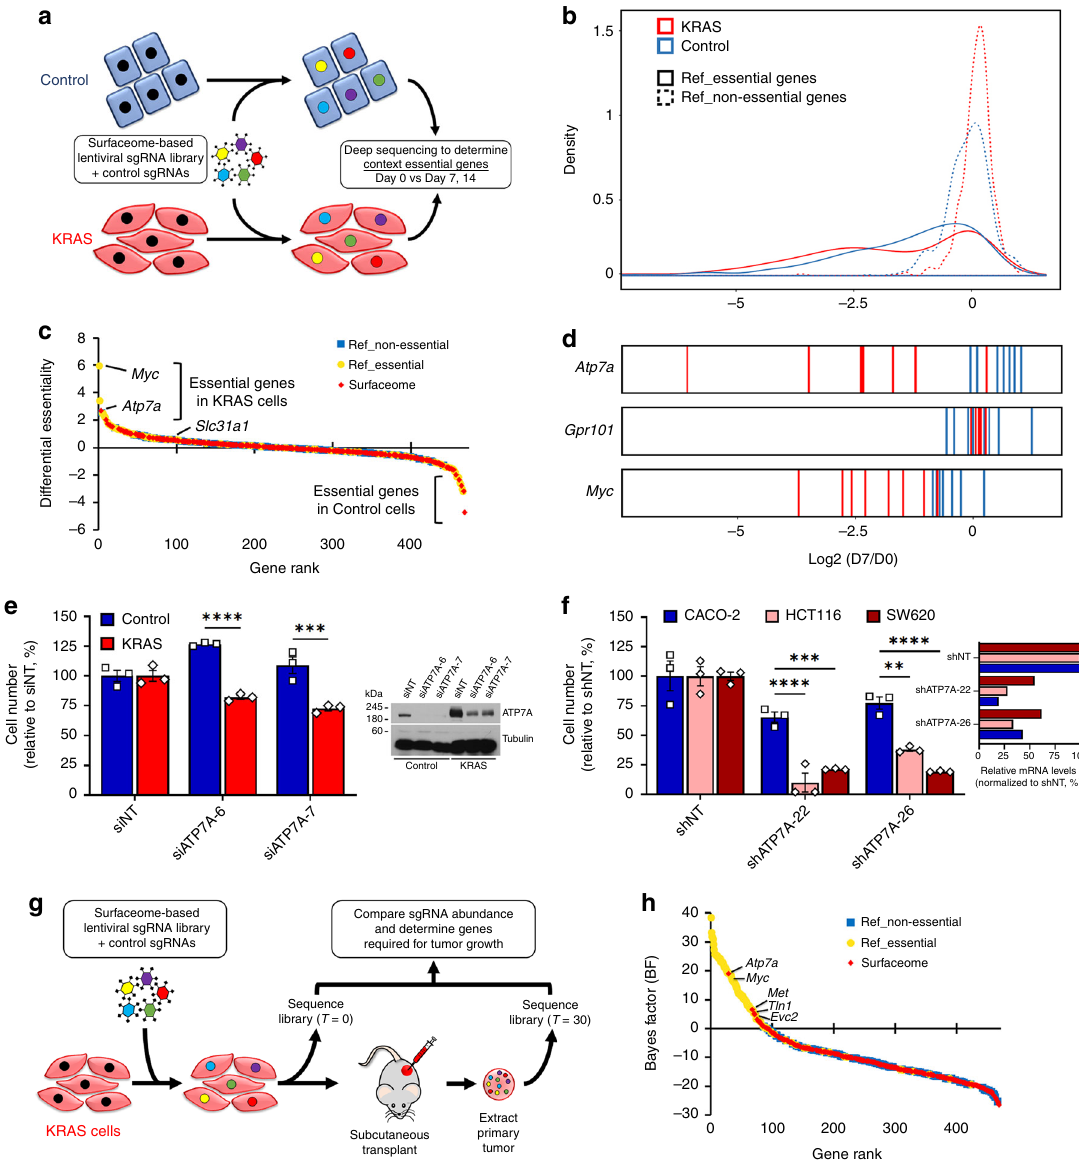
Fig. 2 Identi fi cation of ATP7A as a vulnerability for KRAS-addicted CRC cells. a Experimental design for identi fi cation of KRAS-speci fi c vulnerabilities by in vitro CRISPR/Cas9 screening. b Graph depicting the fold-change distributions of gRNAs targeting essential (solid lines) and nonessential (dashed lines) genes at day 7 after infection of Control and KRAS cells with KRAS-library. c Waterfall graph showing differential essentiality scores between Control and KRAS cells, depicting genes coding for cell-surface proteins signi fi cantly altered by KRAS G12V (red diamonds) and reference genes coding for proteins known to be essential (green circles) or non-essential (blue squares). d Bar graphs illustrating the Log2 FC of the eight gRNAs targeting Atp7a, the non- essential gene Gpr101 and essential gene Myc at day 7 in Control (blue) and KRAS (red) cells. e Bar chart indicating the relative cell viability of Control and KRAS cells after ATP7A knockdown. IB for ATP7A showing the ef fi cient knockdown by RNAi (right). Data represent n = 3 independent experiments with fi ve replicates, and n = 3 independent experiments (right). *** P = 0.0001; **** P < 0.0001. f As in e CRC cells were analyzed for cell viability upon ATP7A knockdown. Graph showing the ef fi cient knockdown of ATP7A as measured by qPCR (right). Data represent n = 3 independent experiments with seven replicates, and two technical replicates (right). **** P < 0.0001 (CACO-2 versus HCT116, shATP7A-22); *** P = 0.0008 (CACO-2 versus SW620, shATP7A-22); ** P = 0.0027 (CACO-2 versus HCT116, shATP7A-26); * P < 0.0001 (CACO-2 versus SW620, shATP7A-26). g Experimental design for the signi fi cantly regulated by KRAS G12V (red diamonds), or proteins that are essential (green circles) or non-essential (blue squares). For panels e , f center values and error bars represent mean ± SEM, and signi fi cance was determined using two-way ANOVA with post-hoc Bonferroni ’ s multiple-comparison